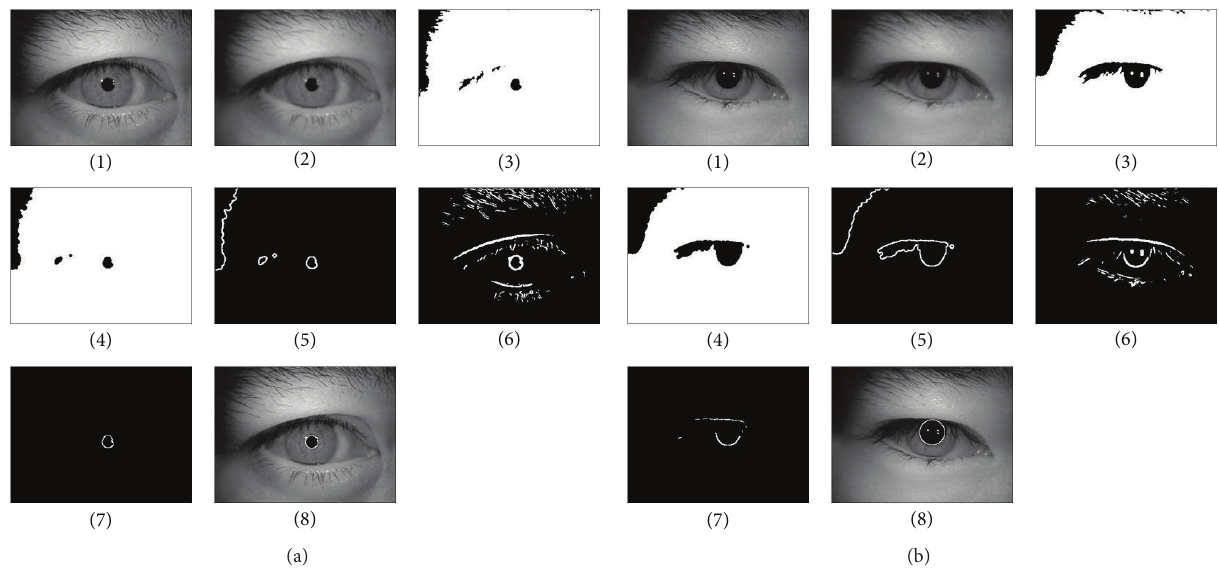
Figure 3: The proposed edge-map creation for pupil localization: (a) optimal edge-map (Image ( 7 )) contains the pupil edges only; (b) optimal edge-map (Image ( 7 )) contains the pupil edges and the false edges. The images in (a) and (b) are ( 1 ) an iris image from CILV3; ( 2 ) smoothed iris image; ( 3 ) binary image, obtained from ( 2 ); (4) cleaned binary image, obtained from ( 3 ); ( 5 ) edge-detected image of ( 4 ); ( 6 ) edge-detected image of ( 2 ); ( 7 ) optimal edge-map, obtained using intersection operation on ( 5 ) and ( 6 ); ( 8 ) pupil localized iris image, obtained using CHT on ( 7 ).